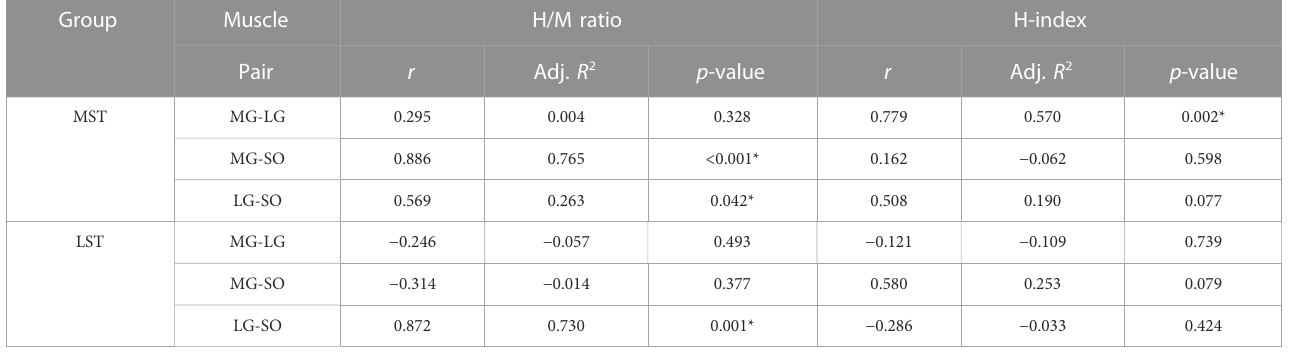
TABLE 1 Pairwise linear correlation coef fi cients of H-re fl ex parameters (H/M ratio and H-index) between triceps surae muscles during standing in both groups. Group